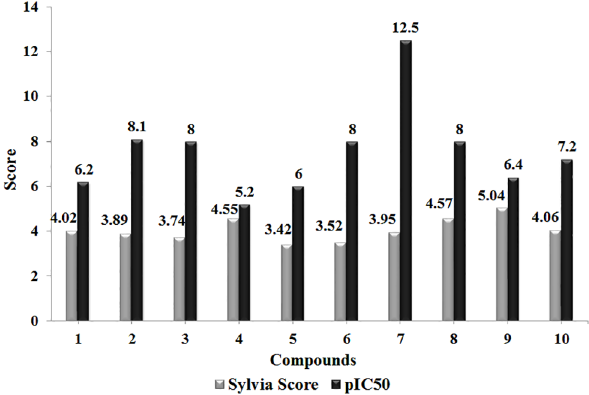
Fig 5. Synthetic accessibility score and expected pIC 50